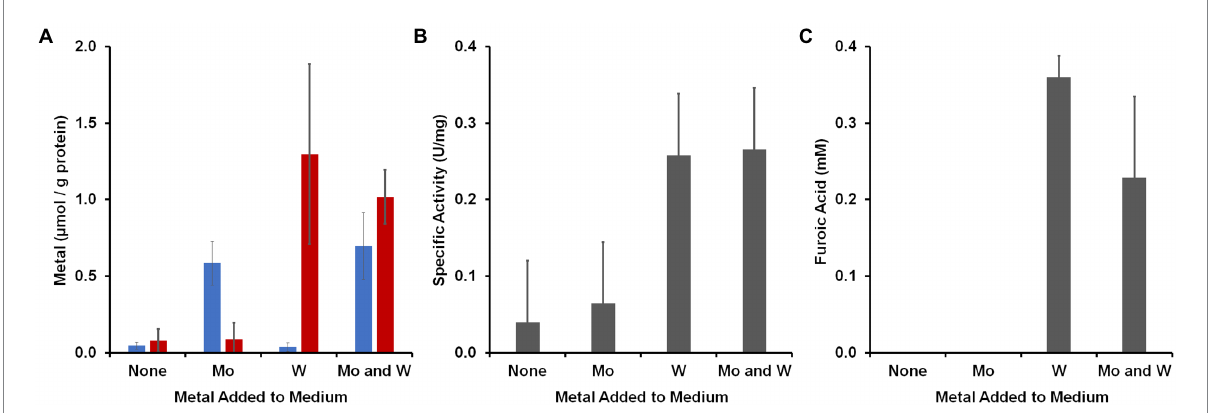
FIGURE 3 Accumulation of metals by B. massiliensis and their effects on benzaldehyde oxidation activities. The organism was grown in base medium containing 2 g/l yeast extract with and without added W or Mo (100 nm). (A) Intracellular accumulation in the cytoplasmic extract of W (red) and